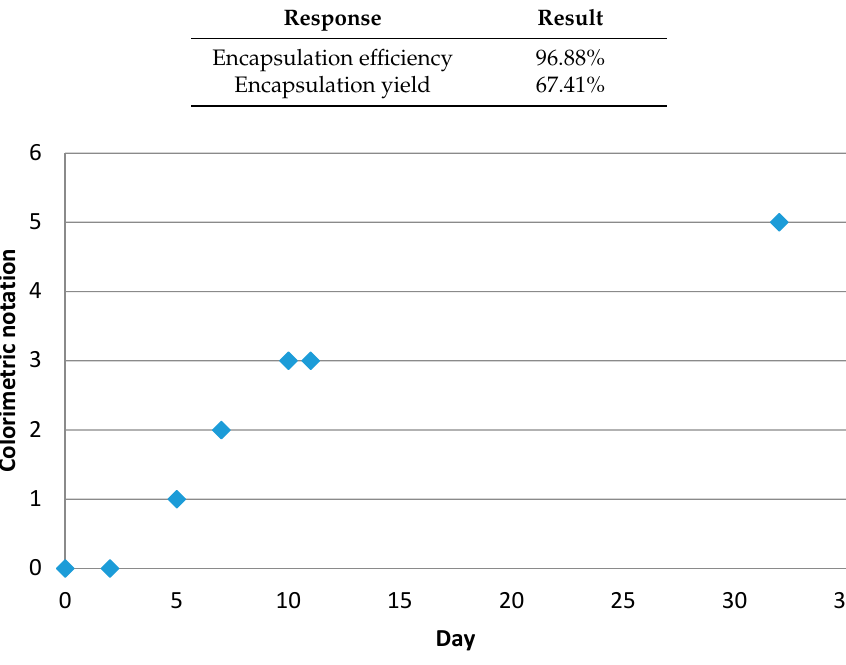
Figure 10. Evolution of stability as a function of time.